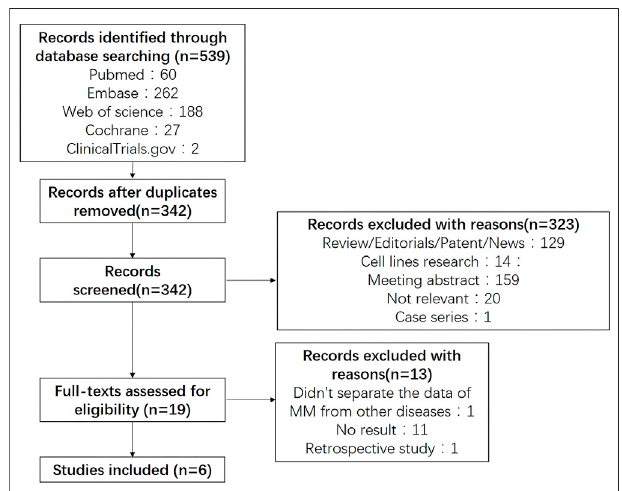
FIGURE 1 | Flow diagram showing the search